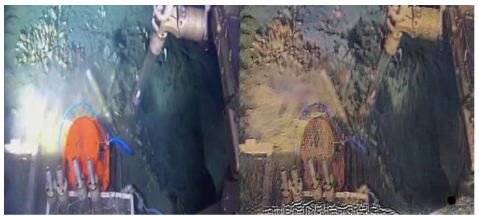
Figure 1. CycleGAN enhancement of an underwater image with an inappropriate